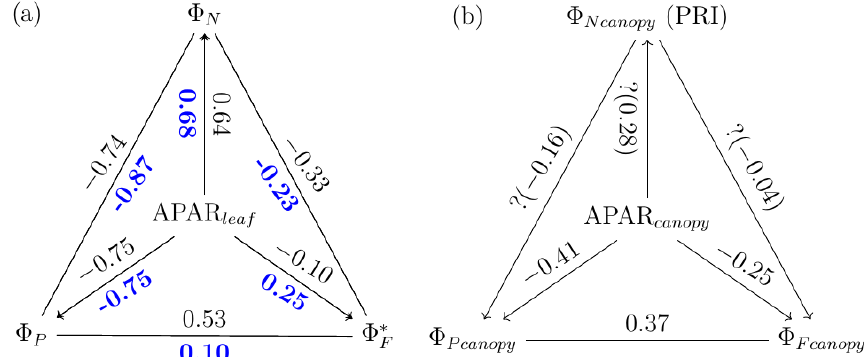
Figure 11. Pearson correlation coefficients between absorbed PAR (APAR leaf and APAR canopy ) and light use efficiencies for all data ob- tained for a corn canopy across the 2017 growing season at both leaf (a) and canopy levels (b) . Light use efficiency of photochemistry ( (cid:56) P ), relative fluorescence emission efficiency ( (cid:56) ∗ ) and efficiency of variable heat dissipation ( (cid:56) N ) of sunlit leaves and shaded leaves (in- F dicated in bold blue text) during daytime (09:00 to 17:00LT) are obtained from in situ active fluorescence measurements made on individual leaves. Canopy light use efficiency of photochemistry ( (cid:56) P ) and of fluorescence ( (cid:56) F ) are approximated by GPP / APAR canopy and canopy canopy F 760 / APAR canopy respectively. PRI is used as an indicator of canopy light use efficiency of variable heat dissipation ( (cid:56) N ), but the exact canopy values of (cid:56) N are unknown (noted with question marks). The leaf level and canopy level variables had 10min and 30min resolutions, canopy